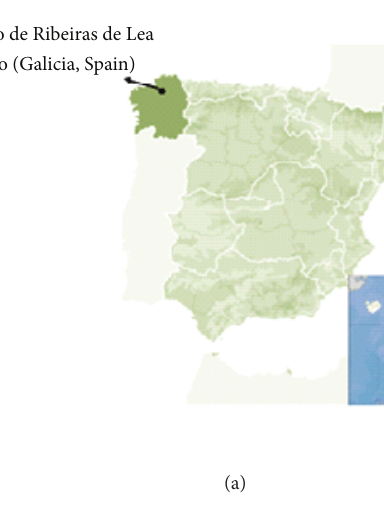
Figure 1: Geographical location of the study area (a). Field digital elevation model (b).